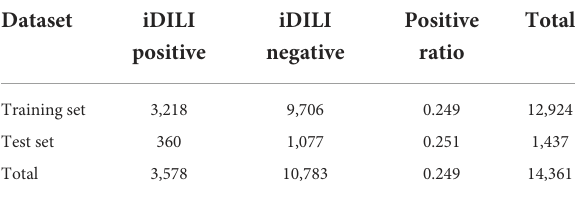
TABLE 1 Data information of preprocessed sentences in